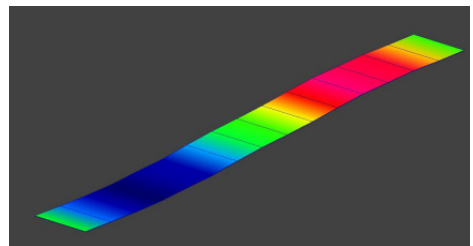
Figure 7. Automatically generated model graph.